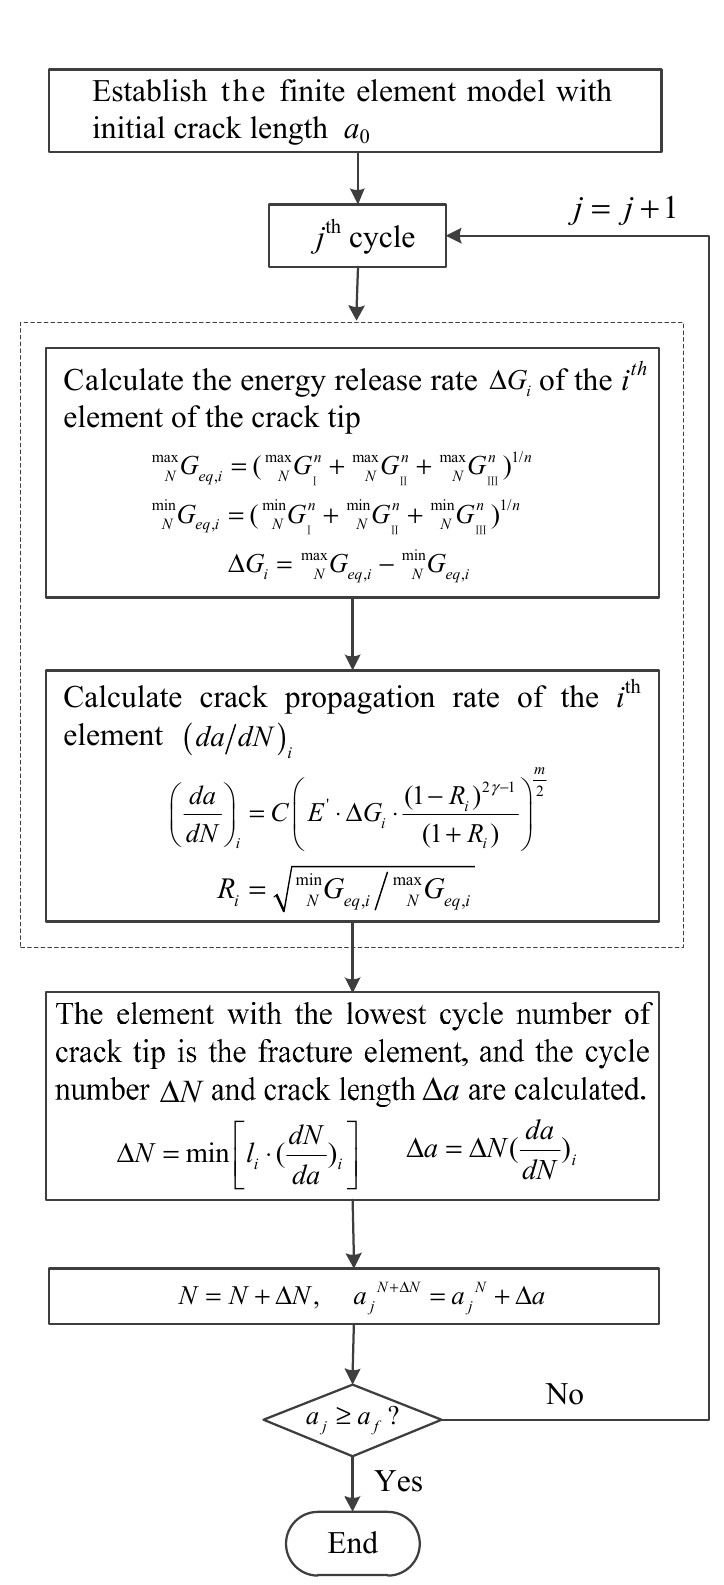
Figure 8. Flow chart of FCP considering R effects based on the XFEM.